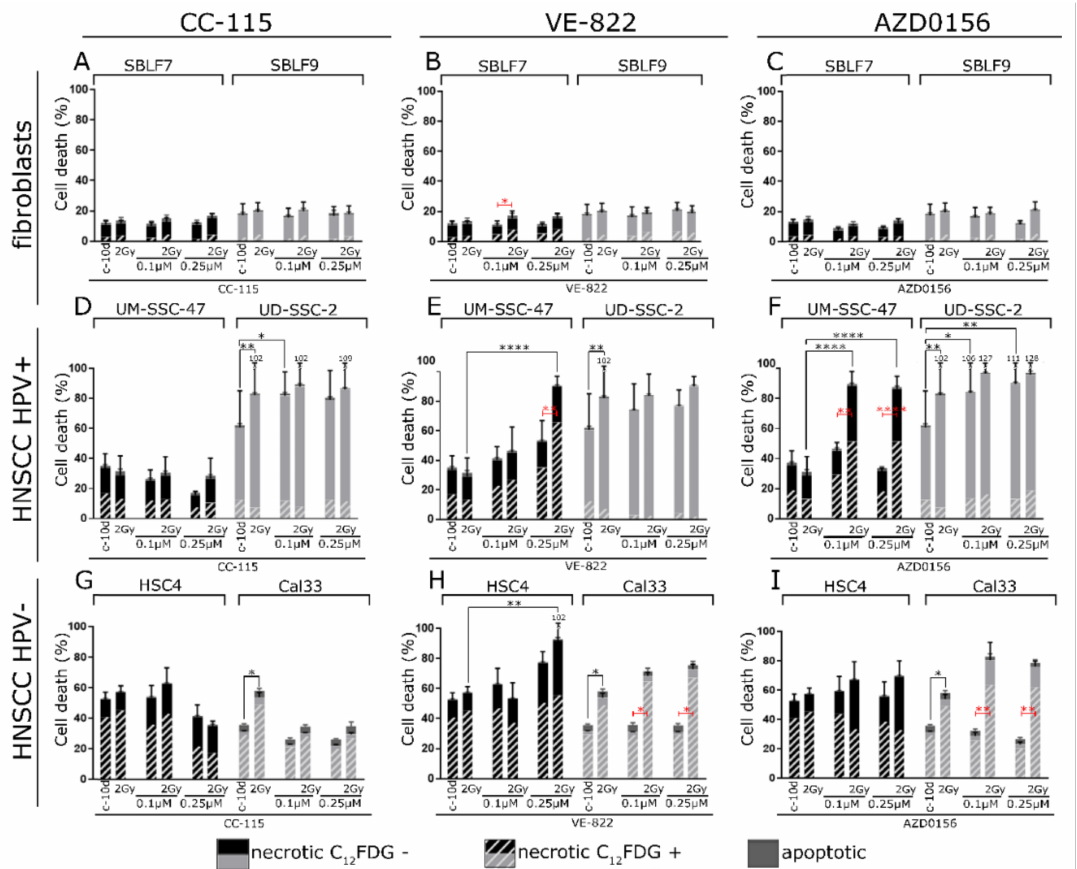
Figure 4. Cell death in two fibroblasts cell cultures, two HPV + and two HPV- HNSCC cell lines. Distribution of early apoptotic cells, C 12 FDG positive and C 12 FDG negative cells among the necrotic cells. Cells were treated by 2 Gy IR alone, kinase inhibitor alone, or combined kinase inhibitor and 2 Gy IR. Fibroblasts cell cultures SBLF7 and SBLF9 treated with ( A ) DNA-PK and mTor inhibitor CC-115, ( B ) ATR inhibitor VE-822, and ( C ) ATM inhibitor AZD0156. UM-SCC-47 and UD-SCC-2 HPV + HNSCC cells treated with ( D ) DNA-PK and mTor inhibitor CC-115, ( E ) ATR inhibitor VE-822, and ( F ) ATM inhibitor AZD0156. HSC4 and Cal33 HPV- HNSCC cells treated with ( G ) DNA-PK and mTor inhibitor CC-115, ( H ) ATR inhibitor VE-822, and ( I ) ATM inhibitor AZD0156. Error bars indicate standard deviation for apoptotic cells (grey) and C 12 FDG negative necrotic cells (black). Each experiment was repeated three times at least and controls at least five times. p -values shown for Holm–Sidak multiple comparisons test in black and red colors. p -values refer to the whole proportion of necrotic cells. * p < 0.05; ** p < 0.01; *** p < 0.001; **** p <